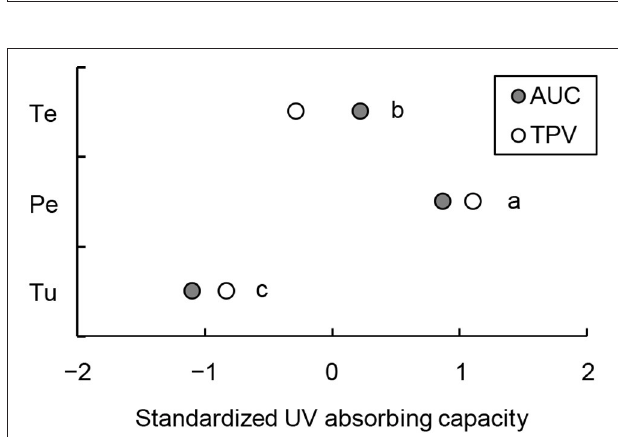
Table S1 ) with literature data (Harborne and Corner,